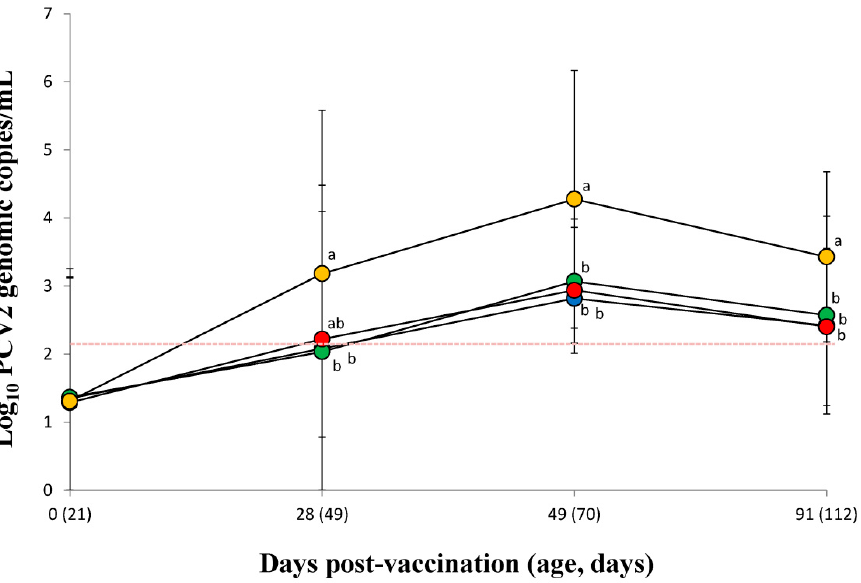
Figure 2. Mean values of the genomic copy number of PCV2d DNA in serum from VacS ( • ), VacPulse ( • ), VacEPIG ( • ), and UnVac ( • ) groups. Variation is expressed as the standard deviation. The detection limit of the assay is 1.3 × 10 2 genomic copy numbers of PCV2d (red dotted line). Different superscripts (a and b) indicate significant ( p < 0.05) different among 4 groups. The amount of PCV2d DNA in serum from the needle ‐ free device (VacPulse) group at 49 dpv showed non ‐ inferiority to conventional needle ‐ syringe injection (VacS group) (95%CI 0.44 to 0.20, non ‐ inferiority margin 0.29). The upper limits of the one ‐ sided 95% CI on the difference in the amount of PCV2d DNA in the serum from the VacPulse and VacEPIG groups at 91 dpv (95%CI for the VacPulse group 0.41 to 0.46 and the VacEPIG group 0.27 to 0.61) exceeded non ‐ inferiority margin (0.24), indicating the outcome did not show non ‐ inferiority (Figure 3).